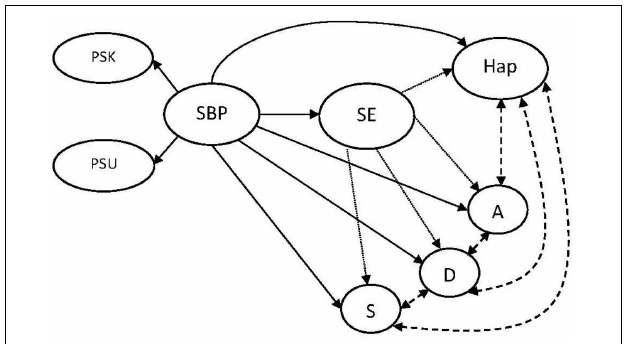
FIGURE 1 | The proposed structural equation model. Solid lines denote regression weights and dashed lines denote correlations. PSK, strength-based parenting knowledge component; PSU, strength-based parenting use component; SBP, strength-based parenting; SE, self-efficacy; Hap, happiness; A, anxiety; D, depression; S,